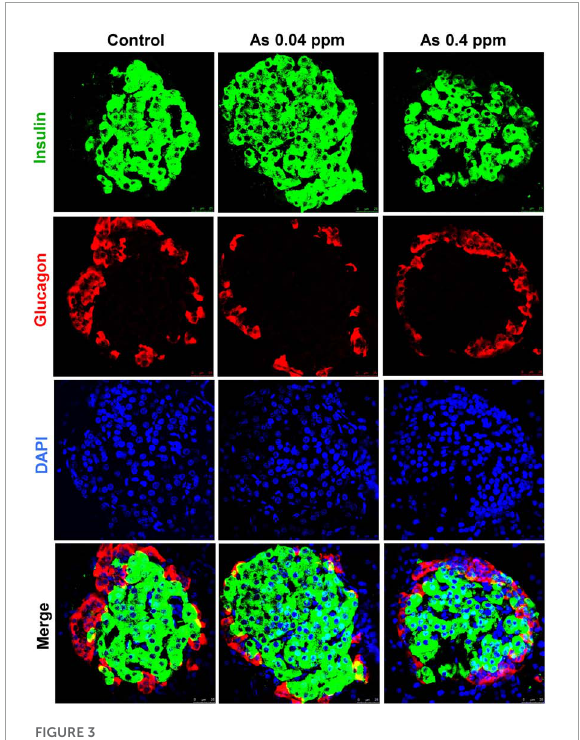
FIGURE3 Effect of prenatal As exposure on the pancreas. The levels of insulin and glucagon were also determined through the IHC of the pancreas isolated from 38 weeks old